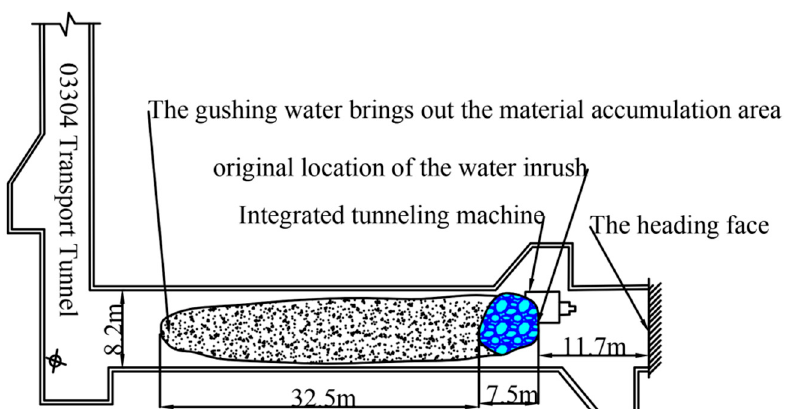
Figure 4. Schematic diagram of plane analysis of the water inrush point.